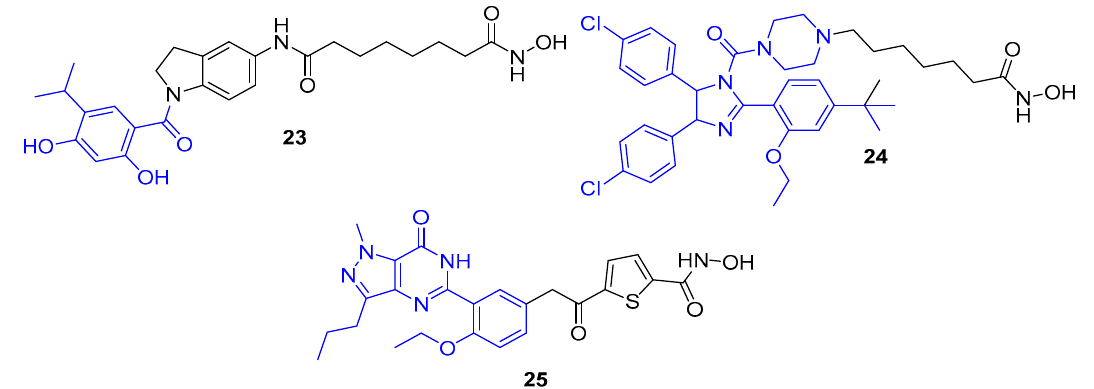
Figure 8. Other HDAC6-selective dual inhibitors. Components: HDAC inhibitor (black) and moiety for inhibition of secondary protein target (blue).